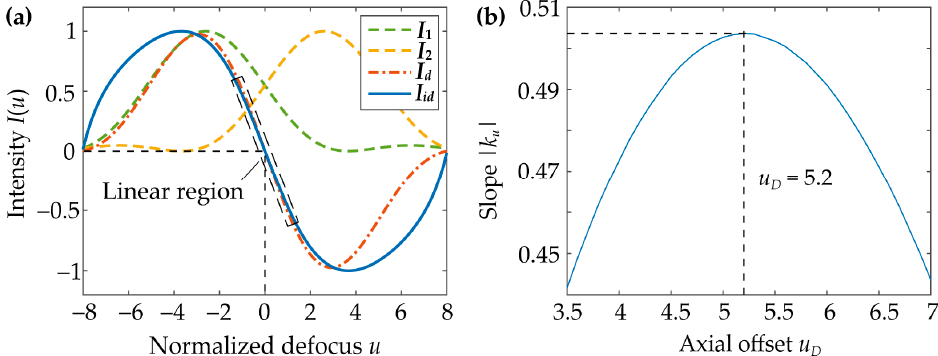
Figure 2. ( a ) Normalized axial intensity response signals I 1 and I 2 obtained from detectors, differential intensity response signal I d of BADCM, and improved intensity response signal I id of IDCM. The curves of BADCM and IDCM are approximately linear in the linear region, and their null points correspond to the normalized defocus u = 0. ( b ) The slope of the BADCM’s axial response curve as a function of axial o ff set u D . The maximum slope corresponds to u D = 5.2.